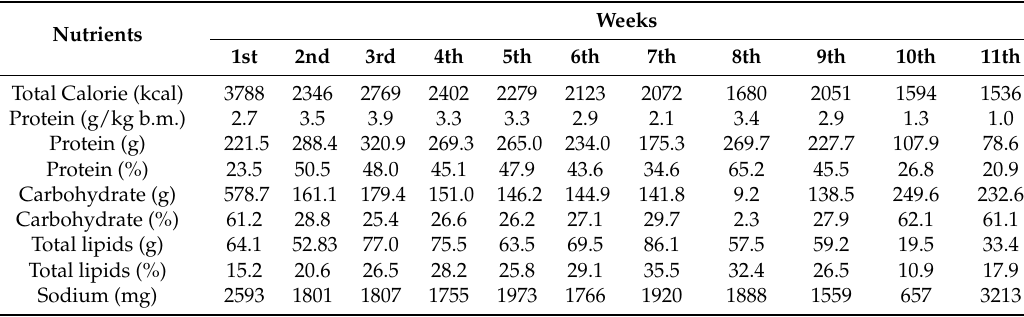
Table 2. Food intake during the 11